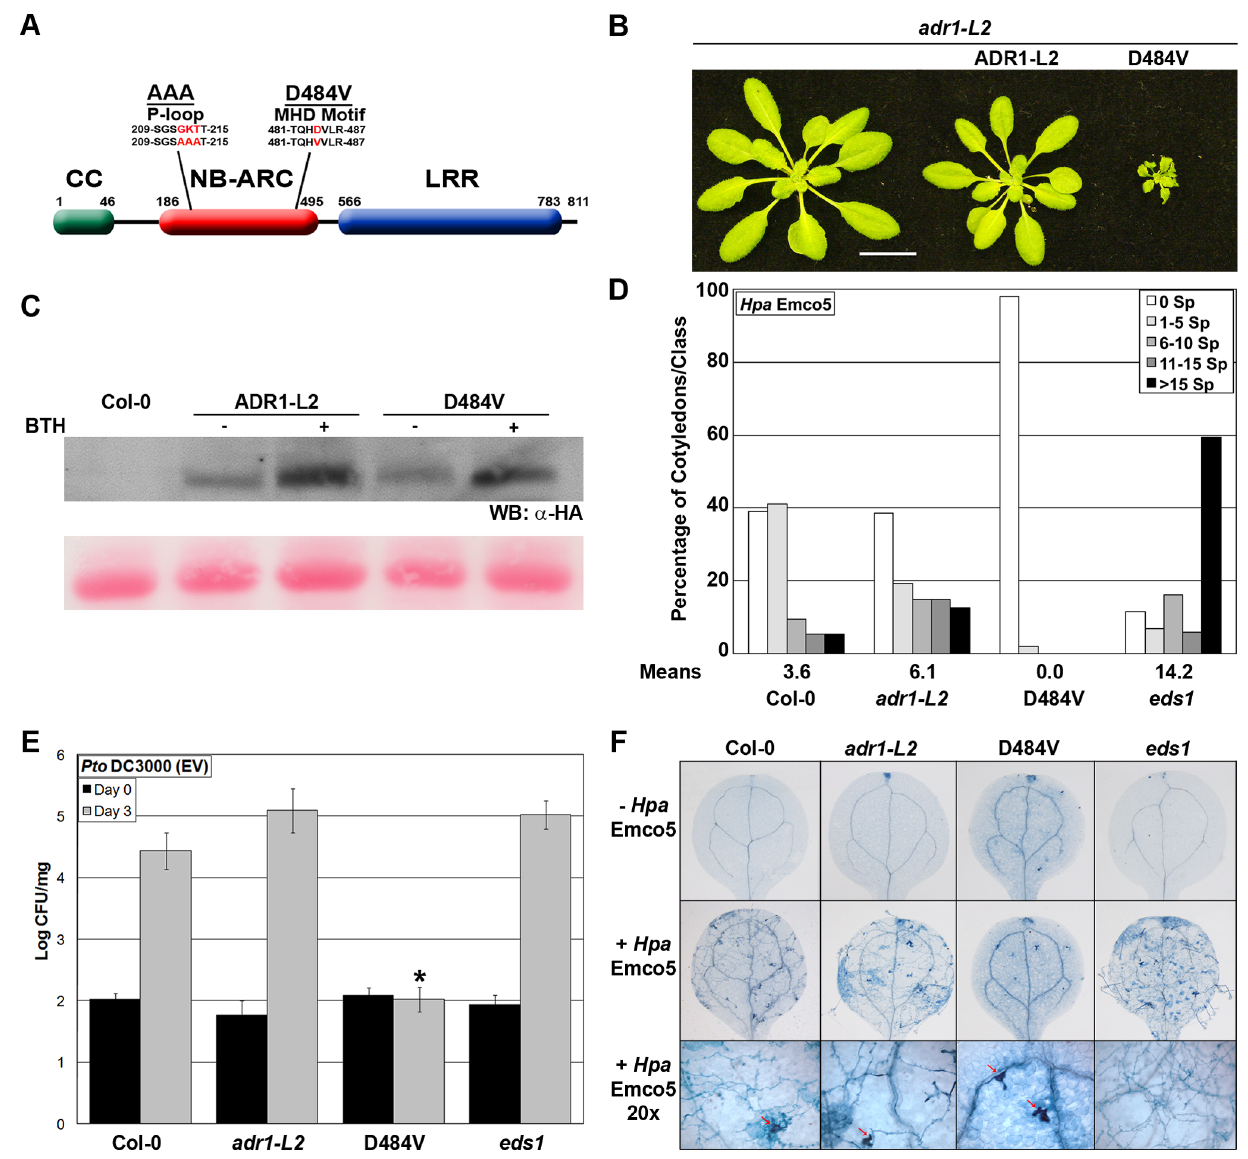
Figure 4. ADR1-L2 D484V ectopically activates basal defense. (A) Schematic representation of ADR1-L2 showing the P-loop and MHD mutations used in this study. (B) Morphology of five-week-old adr1-L2 , and adr1-L2 complemented with pADR1-L2::ADR1-L2-HA or pADR1-L2::ADR1-L2 D484V -HA , showing relative size. White bar is 2 cm. (C) Western blot of HA-tagged protein from the indicated genotypes before and after BTH application. Protein was extracted from plants, run on a denaturing gel and probed with anti-HA antibody. Ponceau-stained blot shows relative loading. (D) Ten- day-old seedlings were inoculated with 5 6 10 4 sporangia/mL Hpa Emco5 via spray inoculation. Sporangiophores per cotyledon were counted 4 dpi, with an average of 80 cotyledons per genotype counted. Sporangiophore counts were classified into: no sporulation (0 sporangiophores/cotyledon), light sporulation (1–5), medium sporulation (6–10), heavy sporulation (11–15), or very heavy sporulation ( . 15). Means of sporangiophore per cotyledon are listed below the graph. (E) Twenty-day-old seedlings were dip-inoculated with Pto DC3000(EV). Bacterial growth was assayed at 0 and 3 dpi. Values are mean cfu/mg 6 2 6 SE, n=4. Asterisk indicates significant difference (Post Hoc test, p , 0.0001). (F) Trypan blue stained leaves from (D) and magnified sites (20 6 ). Leaves were collected and stained 4 dpi. Red arrows indicate HR